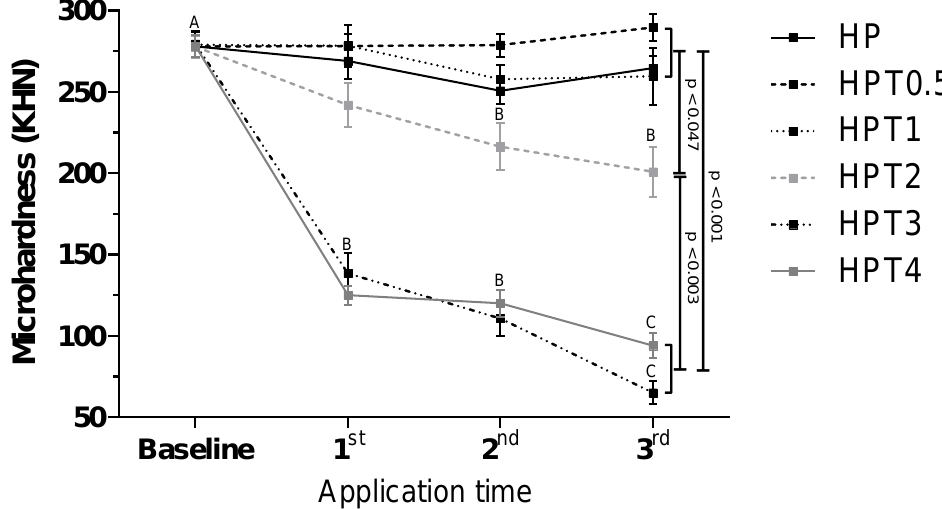
Figure 3. Surface microhardness (KHN) of different bleaching treatment 24 h after application. Legend: Means and standard deviation followed by different letters indicate statistical differences according to two-way repeated measures, ANOVA and Bonferroni test, with significant level set at 5%. Uppercase letters compare color parameters over time within bleaching agents. p -Values indicate statistically significant difference of bleaching treatment groups at third application time. N = 10 specimens/group. HP: hydrogen peroxide; T: titanium